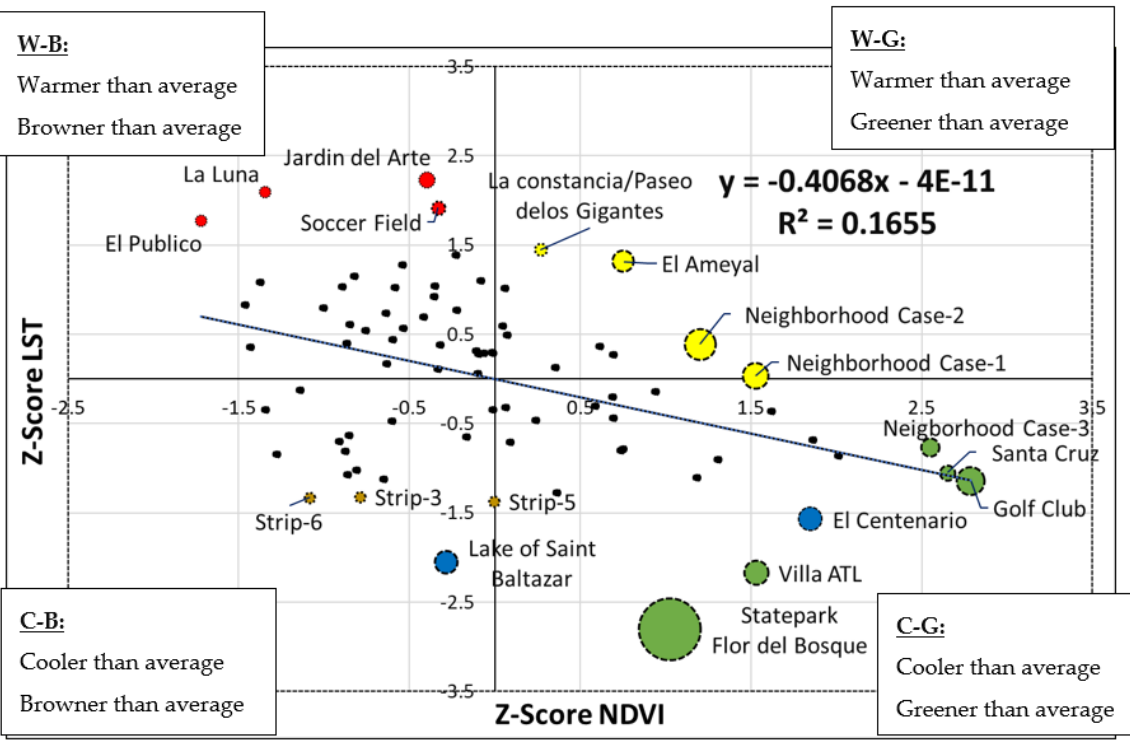
Figure 15. Relationship of NDVI z-score against the LST z-score for all 80 urban green spaces (1 May 2000). The colored circles represent the relative size of the UGS, with blue circles representing UGSs with waterbodies greater than 1 km 2 . UGSs in the upper left quadrant (warmer-browner quadrant) and the lower right quadrant (cooler-greener quadrant) generally show lower temperatures for areas with high vegetation cover. UGSs in the lower left quadrant (cooler-browner quadrant) show a different trend. At least one of those UGSs (Lake of Saint Baltazar) has a large waterbody, which could explain its relative coolness. UGSs in the upper right quadrant (warmer-greener), such as La Constancia/Paseo de Los Gigantes (#39), El Ameyal (#20), and Neighborhood Case-1 (#60) and Case-2 (#5), are relatively warm compared to their above-average